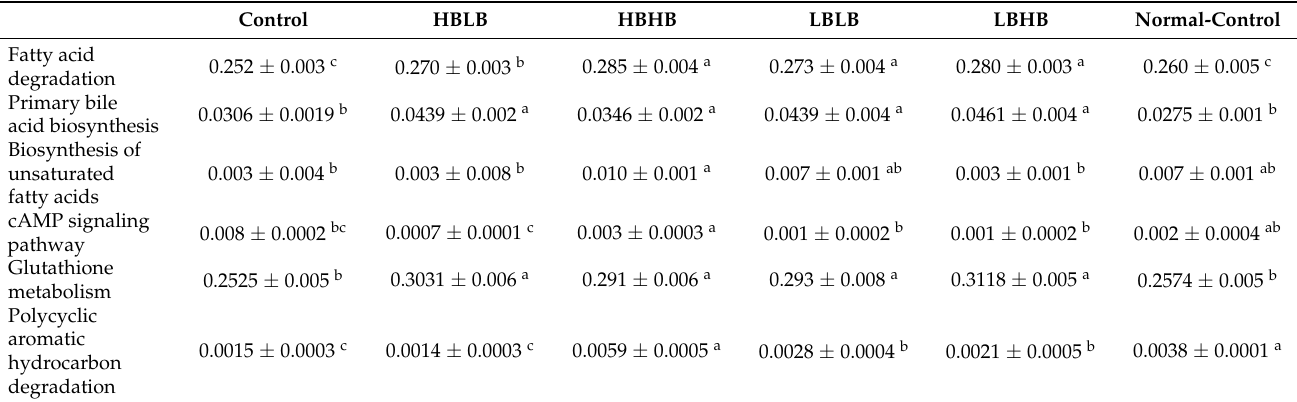
Table 5. Metagenome function of the fecal bacteria from the